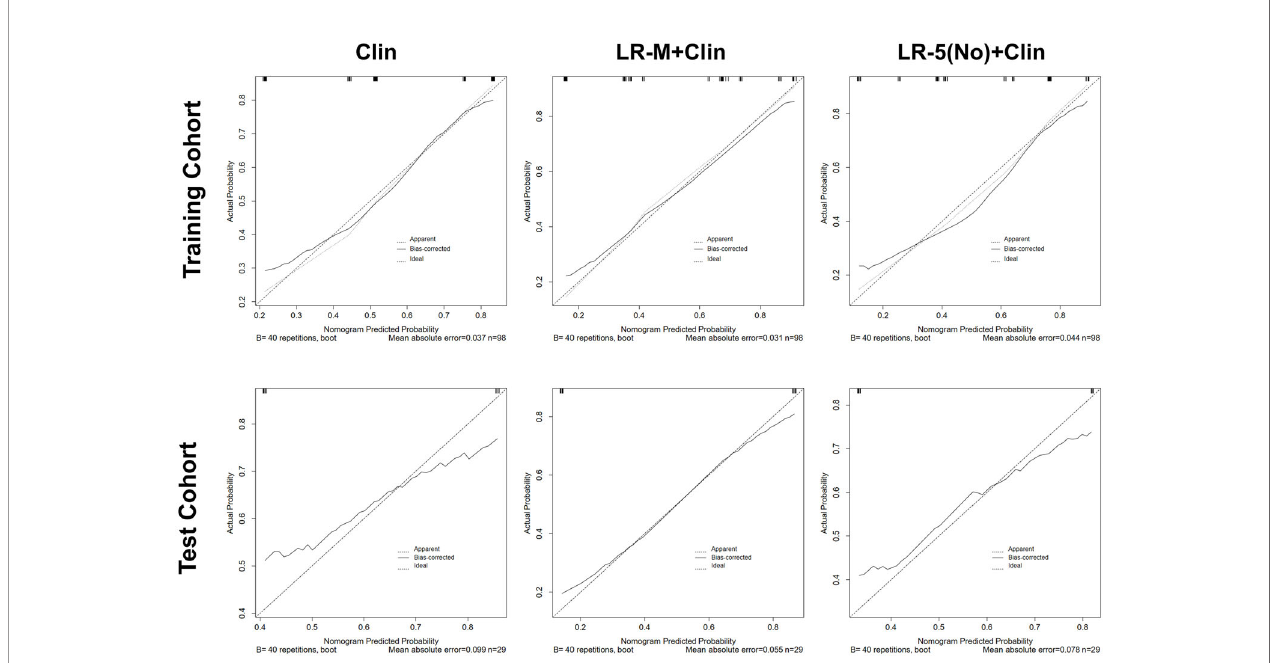
FIGURE 6 | Calibration curve graphics of all models for predicting MVI in HCC patients in the training cohort (upper panel) and test cohort(lower panel). In the calibration curve, X-axis means plotting the predicted probabilities from the model and y-axis means actual survival probabilities. Clin, clinical information; HCC, hepatocellular carcinoma; MVI, microvascular invasion; CEUS; contrast enhanced ultrasound; LR-5, liver imaging reporting and data system category 5; LR-M, liver imaging reporting and data system category